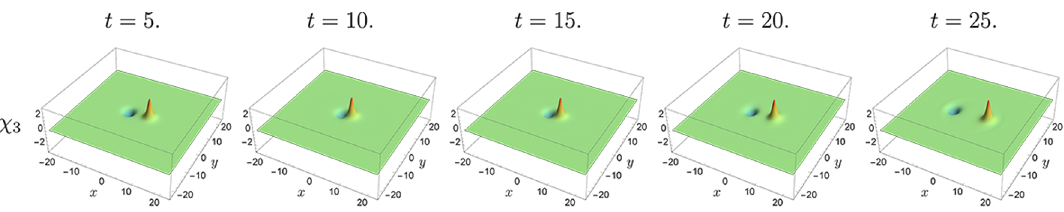
Figure 23 . Trajectories X i ( t ) and Y i ( t ) of two anti-parallel non-Abelian vortices of type II colliding head-on with initial velocities u = 0 . 3 , 0 . 4 , · · · , 0 . 9 (marked on the plots for clarity).